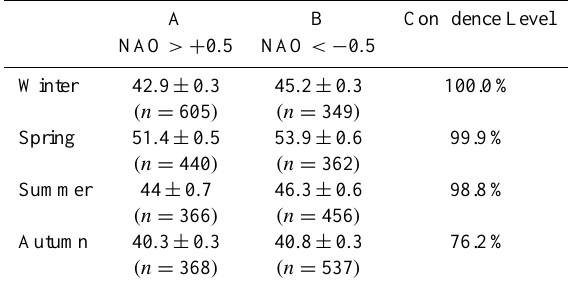
Table 6. Mean surface O 3 for NAO > + 0 . 5 and NAO < − 0 . 5 for each season in the period 1988–2009 with the corresponding stan- dard deviation of the mean. The third column shows the confidence level for the difference between the